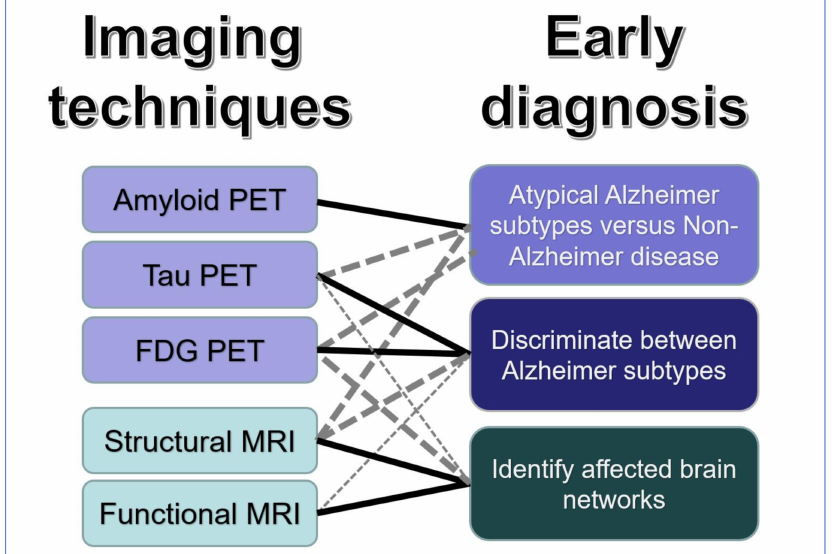
Figure 4. Graphical summary of main